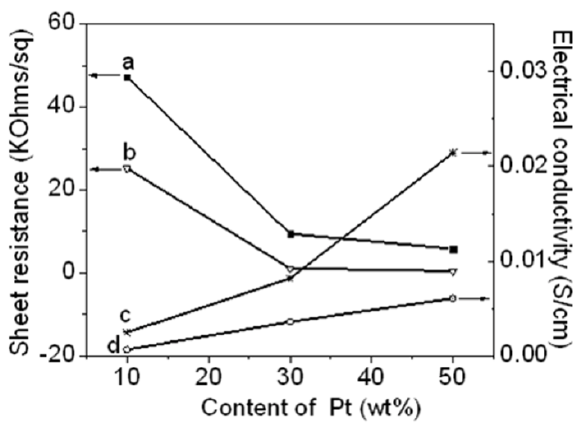
Figure 8. Sheet resistance of ( a ) Pt NPs/r-GO; ( b ) Pt NPs/r-fGO; and electrical conductivity of ( c ) Pt NPs/r-fGO; ( d ) Pt NPs/r-GO as a function of the platinum content in the r-GO